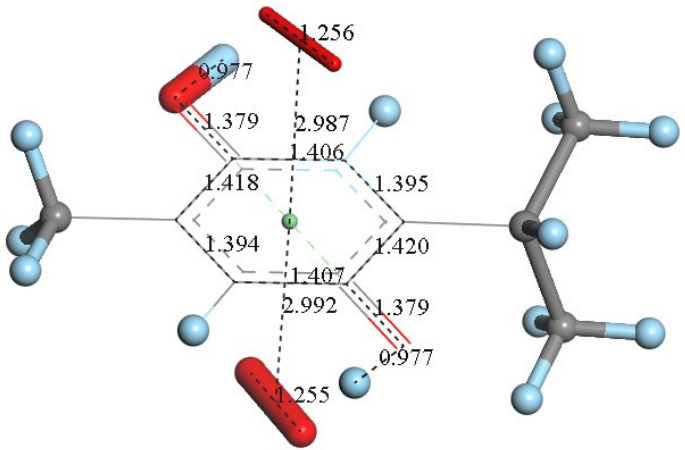
Figure 5. An additional superoxide (large stick style) was π‐π placed below the structure shown in Figure 4F and its DFT minimization shows the neutral final complex [thymohydroquinone- η -O 2 ], obtained for process (b).